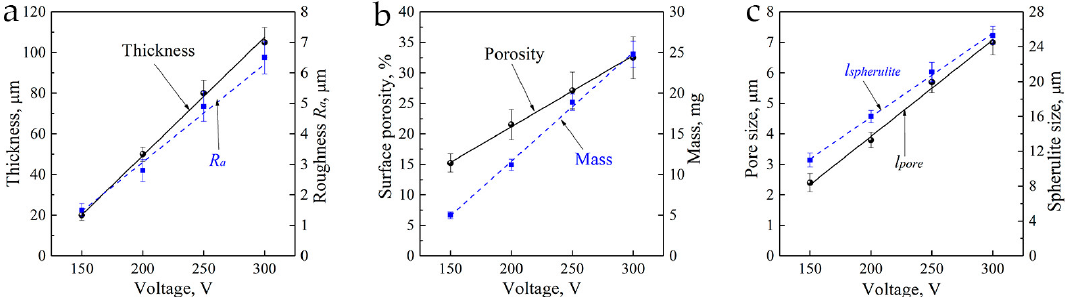
Figure 2. Plots of the coating thickness and roughness, ( a ) surface porosity and mass, and ( b ) size of the spheres and pores ( c ) against the microarc oxidation (MAO)-applied voltage.